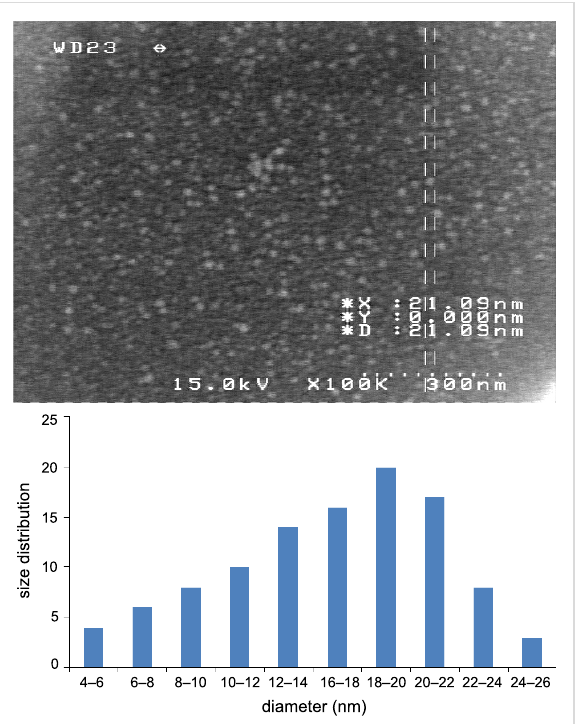
Figure 3: SEM micrograph of compound 1 and histogram indicating the size distribution in the SEM images.